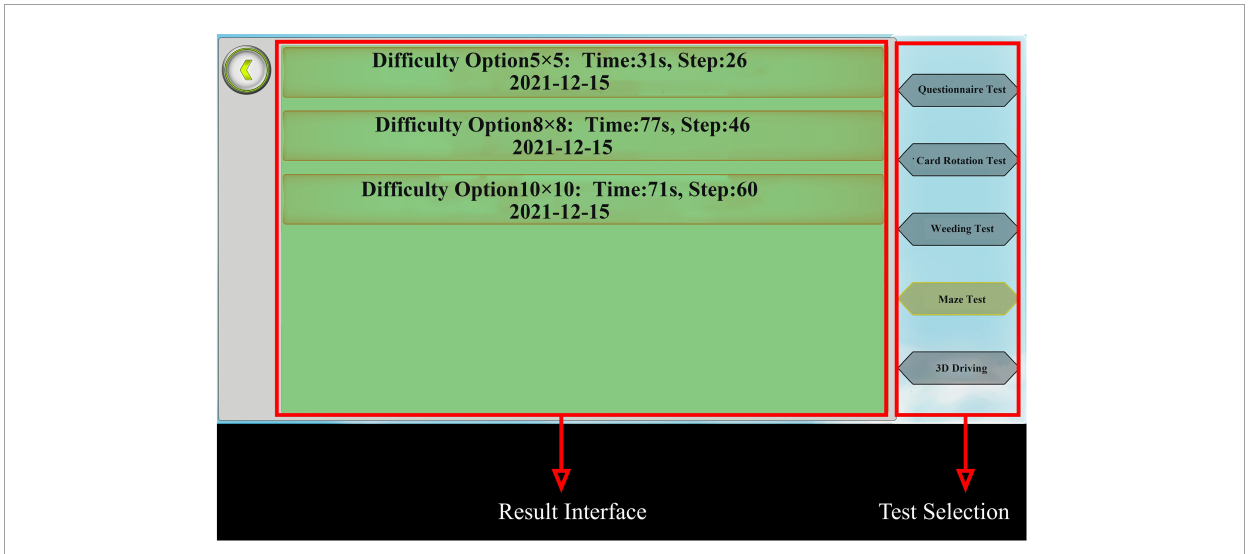
FIGURE9 Result display module. Taking the 8 × 8 maze test results as an example, the results include the number of steps and time for different difficulties of the maze test. Adapted from